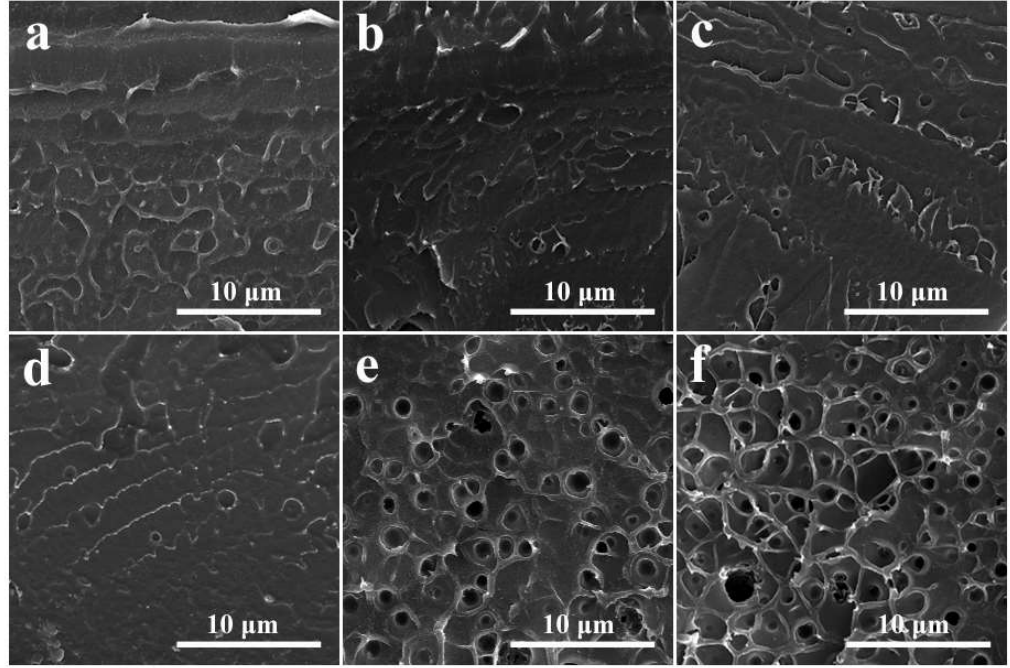
Figure 2. SEM images of ( a ) a SPEEK membrane and SPEEK/SDBS membranes with SDBS contents of ( b ) 2 wt %, ( c ) 4 wt %, ( d ) 10 wt %, ( e ) 15 wt %, and ( f ) 20 wt %.